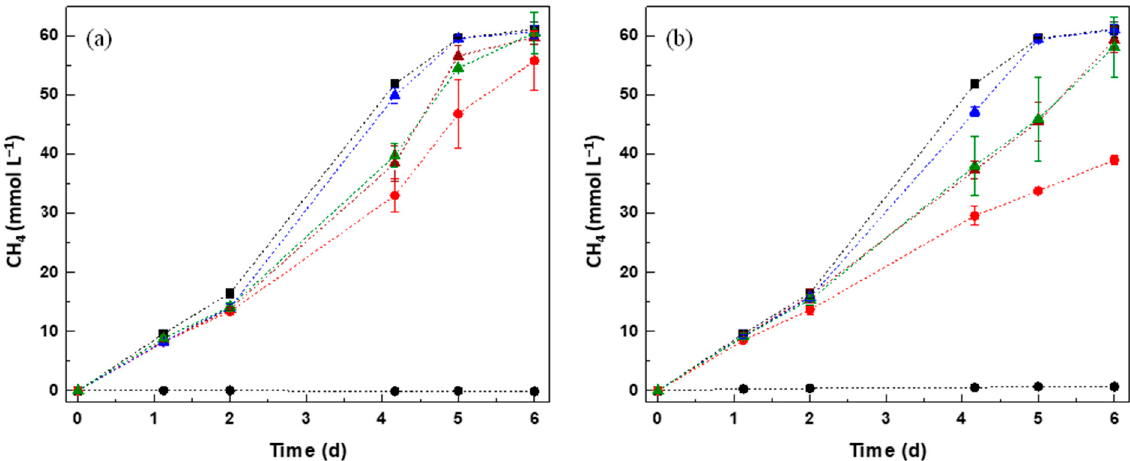
Figure 1. Effect of PFOA ( a ) and PFOS ( b ) on CH 4 production from the anaerobic degradation of VFA, in the presence of CM. Blank assays ( ● ), Controls—biotic assays without PFAS ( ■ ), biotic assays with PFAS ( ● ), biotic assays in the presence of PFAS and: CNT ( ▲ ), AC ( ▲ ), or AC-HNO3 ( ▲ ).